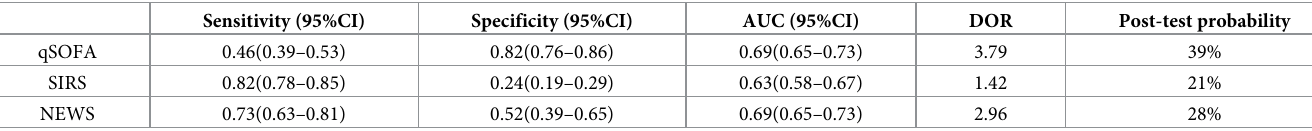
Table 3. Pooled performance characteristics of qSOFA, SIRS, and NEWS for predicting mortality in patients with suspected